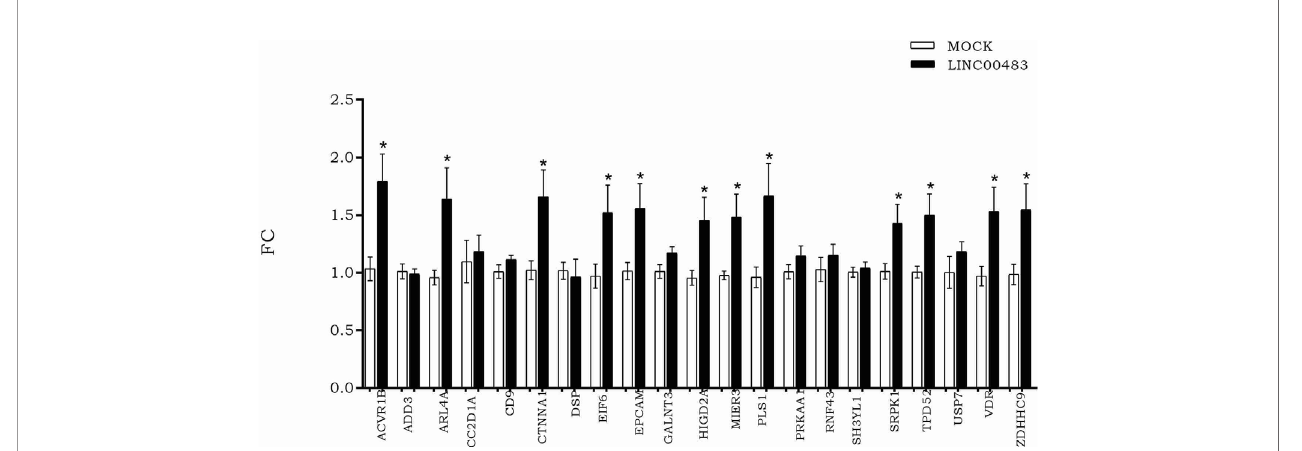
FIGURE 6 | The expression of messenger RNAs (mRNAs) selected as potentially involved in LINC00483 molecular axes after LINC00483 transfection in HCT-116 cells. *p-value < 0.05.